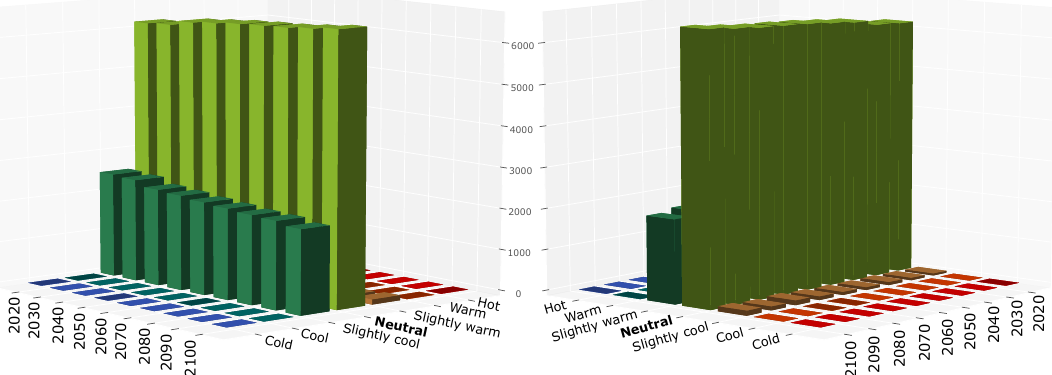
Figure A5. Comfort results taking into account the CTE-2013 standard and the Pamplona weather file generated with Meteonorm based on the IPCC scenario (B1).